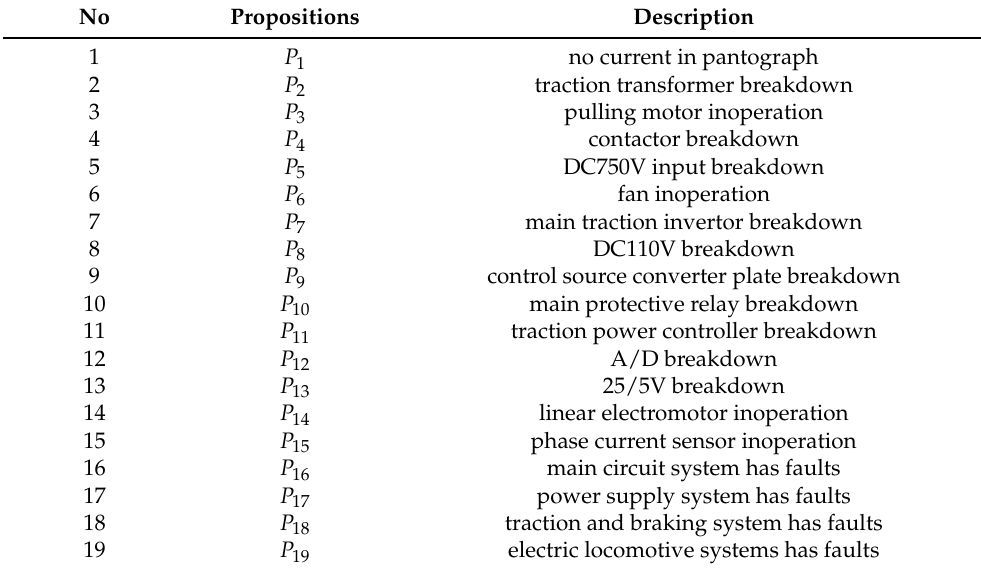
Table 1. Meaning of each proposition in fuzzy production rules for electric locomotive